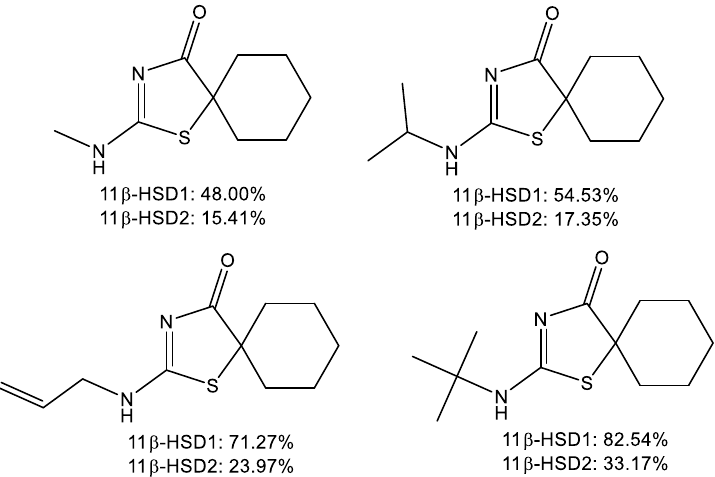
Figure 2. Thiazolone derivatives as selective inhibitors of the 11β -HSD1.